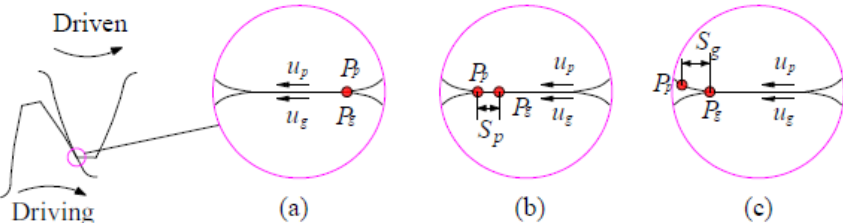
Figure 5. Relative sliding distance between the meshing points on the gear and pinion. ( a ) The starting point of engagement; ( b ) The ending position when the pinion exits the meshing area; ( c ) The ending position when the gear exits the meshing area.